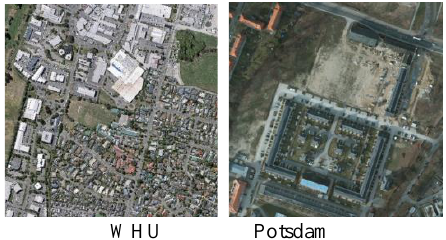
Figure 2 . Example images of the WHU and Potsdam benchmark